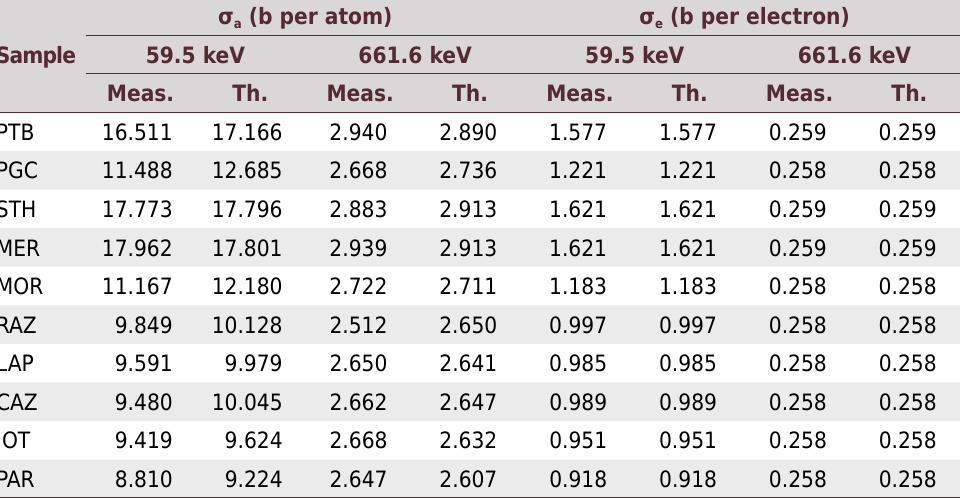
Table 4. Atomic (σ a ) and electronic (σ e ) cross-sections of the samples studied for the 241 Am and 137 Cs radioactive sources